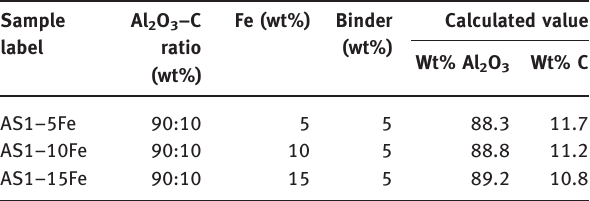
Table 2: Composition of AS1 – iron-blended